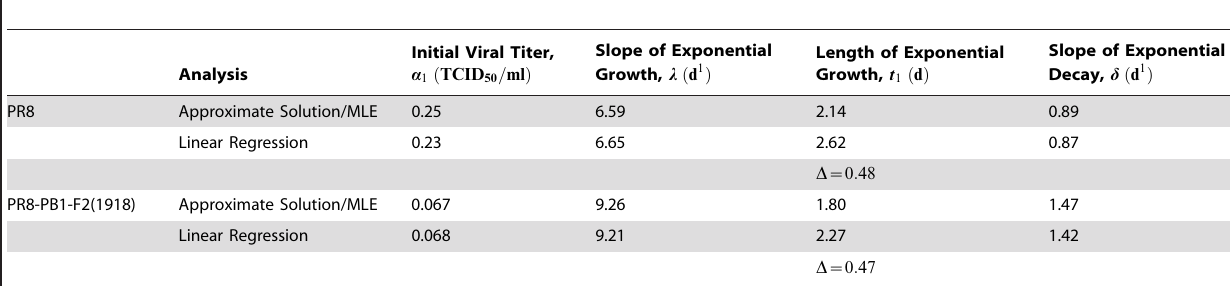
Table 4. Link between linear regression analysis and viral kinetic model estimates of the slope and length of viral growth (Phase I) and the slope of virus decay (Phase II).